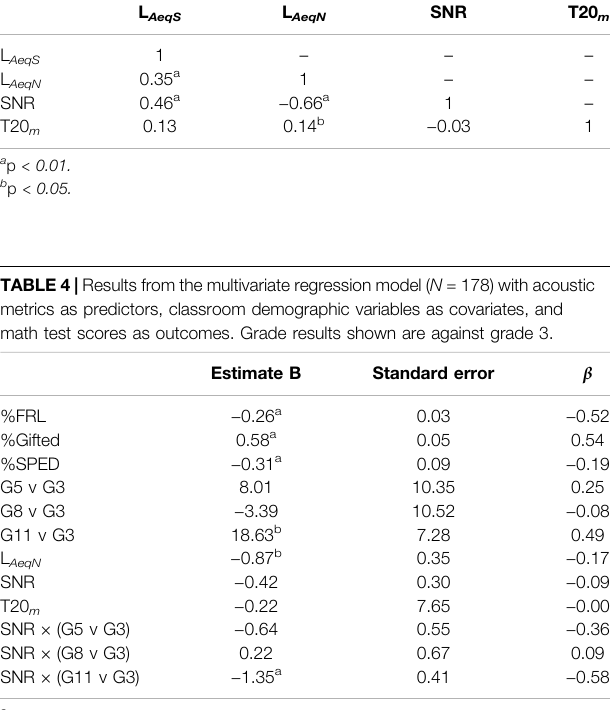
TABLE 5 | Results from the multivariate regression model ( N (cid:1) 180) with acoustic metrics as predictors, classroom demographic variables as covariates, and reading test scores as outcomes. Grade results shown are against grade